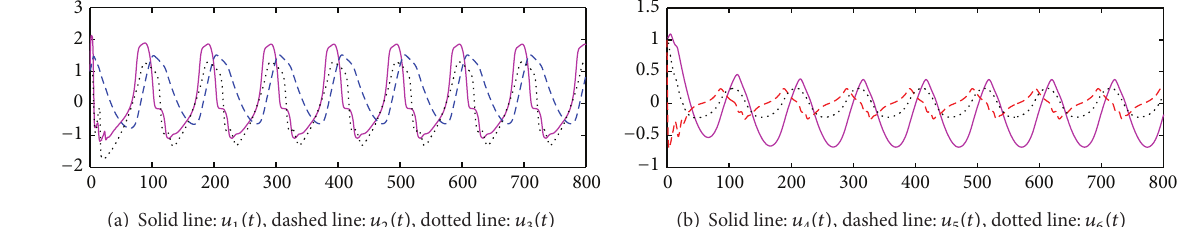
(b) Solid line: 𝑢 4 (𝑡) , dashed line: 𝑢 5 (𝑡) , dotted line: 𝑢 6 (𝑡) Figure 2: Periodic oscillatory behavior, activation function: tanh (𝑢) , and delays: (10, 8, 4).